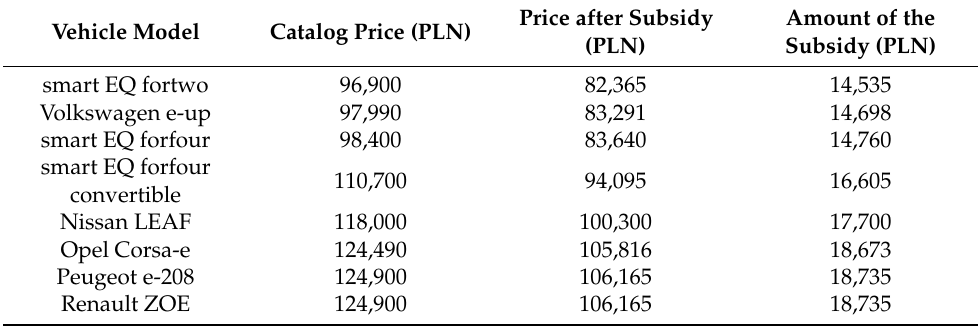
Table 5. Models of electric vehicles eligible for subsidy under the “Green Car—co-financing of the